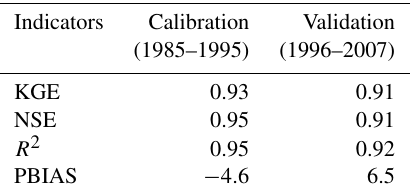
Table 2. Goodness-of-fit statistics of discharge simulation results during the calibration and validation